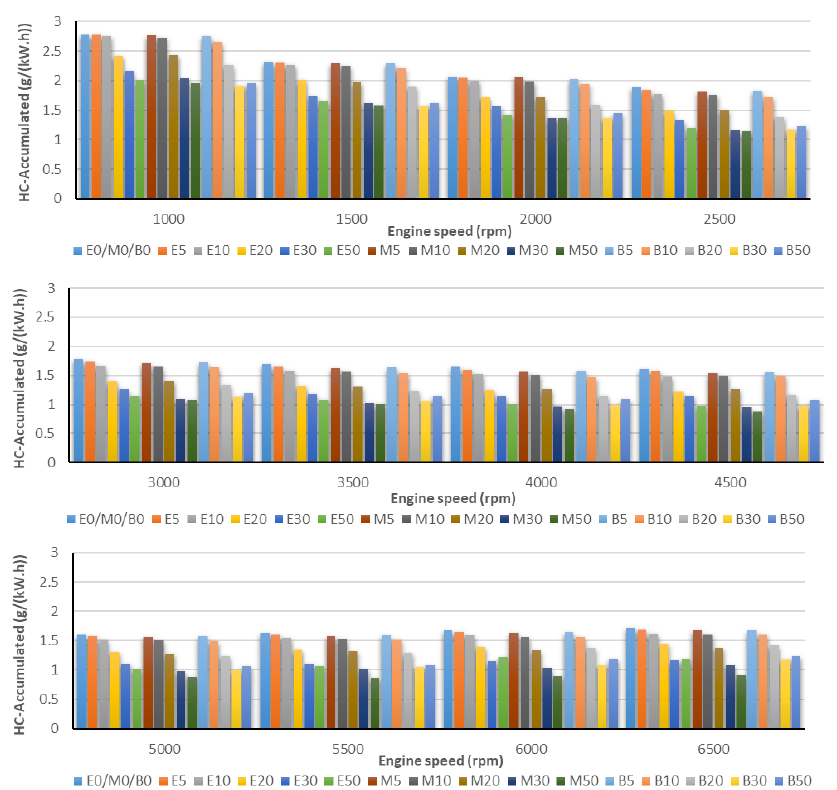
Figure 5. The results for HC emissions obtained by blended alcohols fuels and net gasoline.